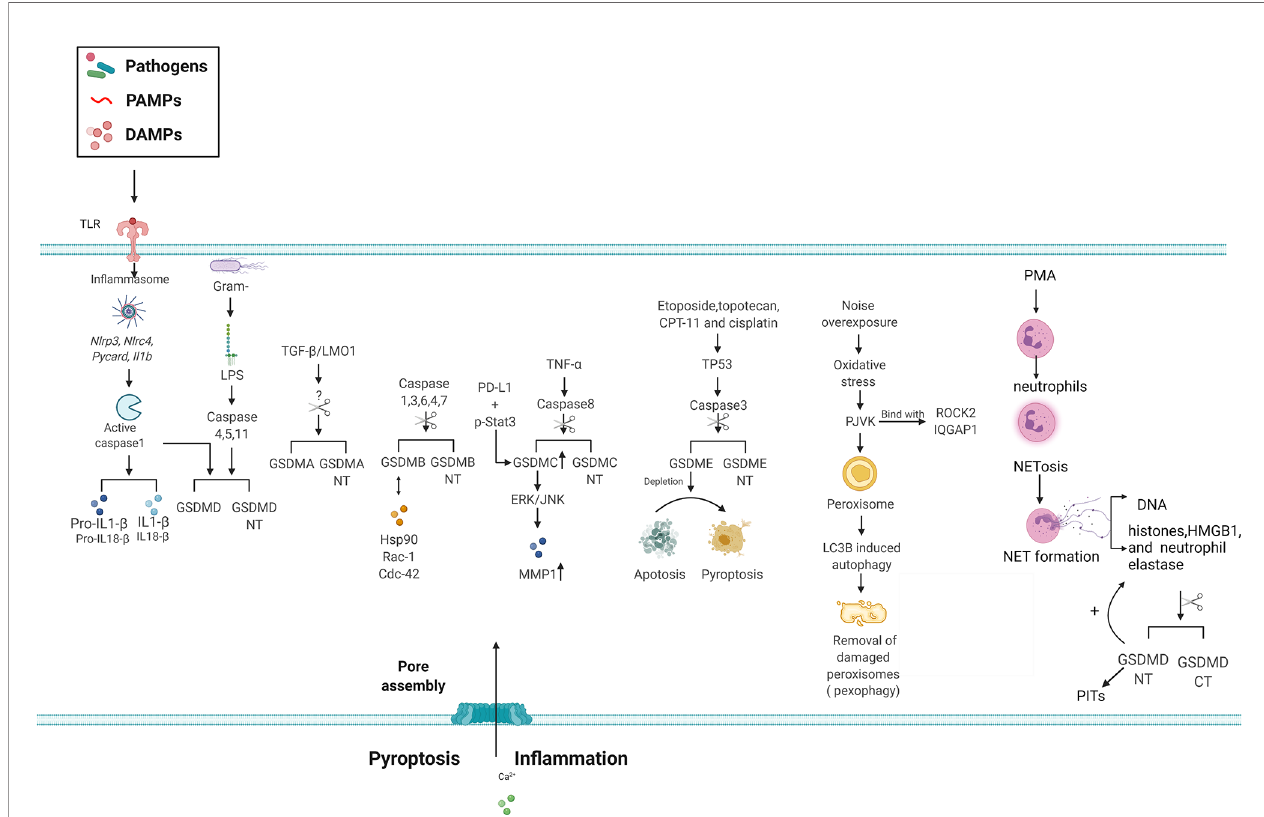
FIGURE 3 | Signaling pathways of GSDM family members in in fl ammasome signaling, pore formation and cell death. GSDMD is involved in pyroptosis via canonical and non-canonical in fl ammasome mediated pathways following cleavage by in fl ammatory caspases. The N-terminal domain of GSDMA-E can bind with membrane lipids of the plasma membrane and form pores, allowing release of the in fl ammatory cytokines IL-1BIL-1B and IL-18 and induction of pyroptosis. However, the in fl ammatory caspase responsible for GSDMA cleavage remain elusive. Various stimuli and upstream signals like PD-L1, TP53 and TNF- a , can lead to GSDMs cleavage and subsequent cell death. GSDMs are able to bind with other molecules, such as Hsp90, Rac-1 and ROCK2, and the following function require further investigation. Alternatively, depletion of GSDME can switch apoptosis to pyroptosis in cells. The ability of PJVK to bind membrane lipids or form pores in the plasma membrane is uncertain, however it is implicated autophagy related pexophagy. In addition, GSDMD leads NETosis as the key effector GSDMD is cleaved by neutrophil elastase during NETosis induced by classic stimulants such as PMA, releasing the active GSDMD-N.GSDMD-N, Gasdermin N-terminal; GSDMA, Gasdermin A; GSDMB, Gasdermin B; GSDMC, Gasdermin C; GSDMD, Gasdermin D; GSDME, Gasdermin E; HSP90, heat shock protein 90; IL-1BIL-1B, interleukin-1 b ; IL-18, interleukin-18; PJVK, Pejvakin; PD-L1, programmed death-ligand1; ROCK2, rho associated coiled-coil containing protein kinase 2; Rac-1, ras- related C3 botulinum toxin substrate 1; Cdc42, cell division cycle 42; IQGAP1, IQ Motif Containing GTPase Activating Protein 1; MMP1, Matrix Metallopeptidase 1; ERK, extracellular regulated protein kinase; JNK,c-Jun N-terminal kinase; TGF- b , transforming growth factor- b ; LOM1, LIM Domain Only 1; PMA,phorbol 12- myristate 13-acetate; Netosis, neutrophil extracellular trap formation (NETosis); PITs: pore induced intracellular